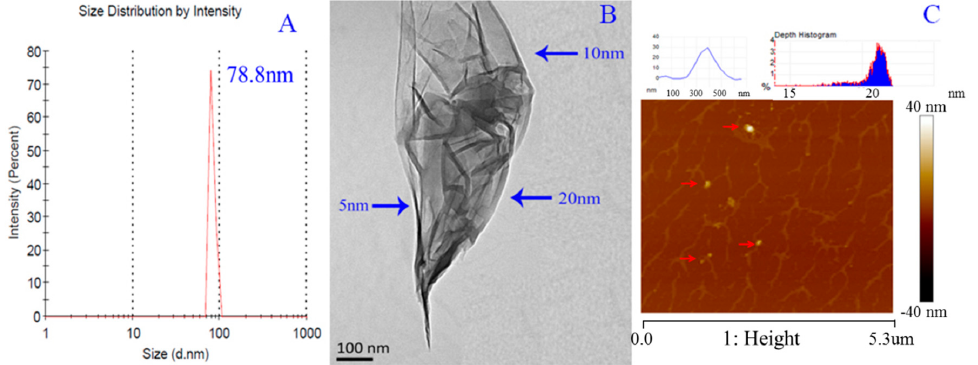
Figure 2. Nano-properties of FA-2-DG, ( A ) DLS size analysis of FA-2-DG in water solution; ( B ) TEM micrograph of FA-2-DG; ( C ) AFM image of FA-2-DG.